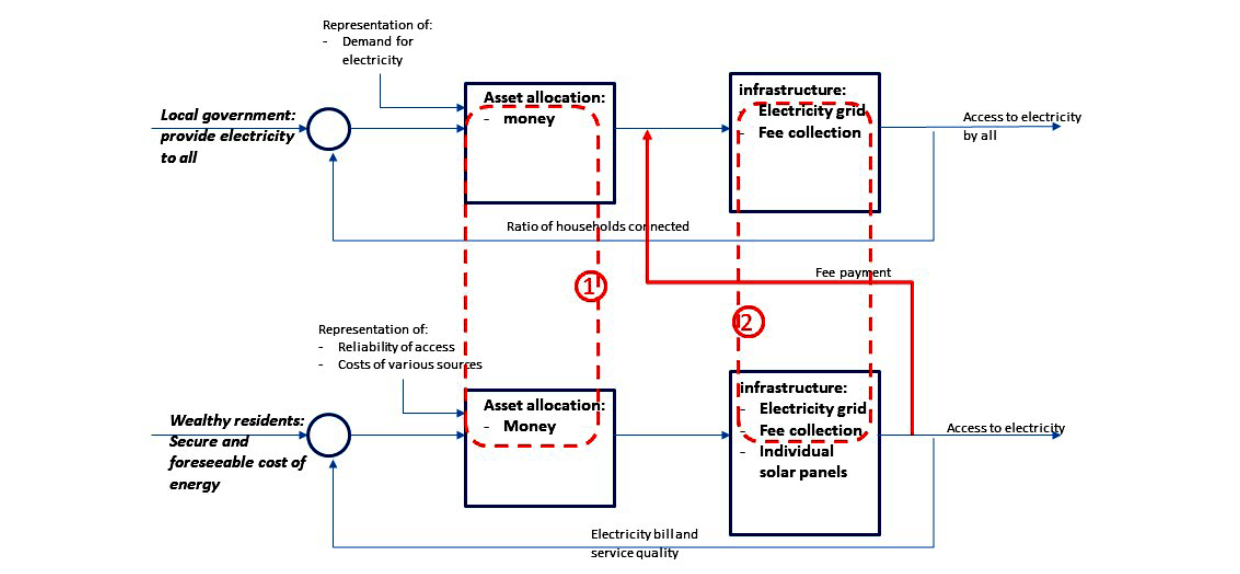
Fig. 6 . Vulnerability transfers observed in solar energy development in South